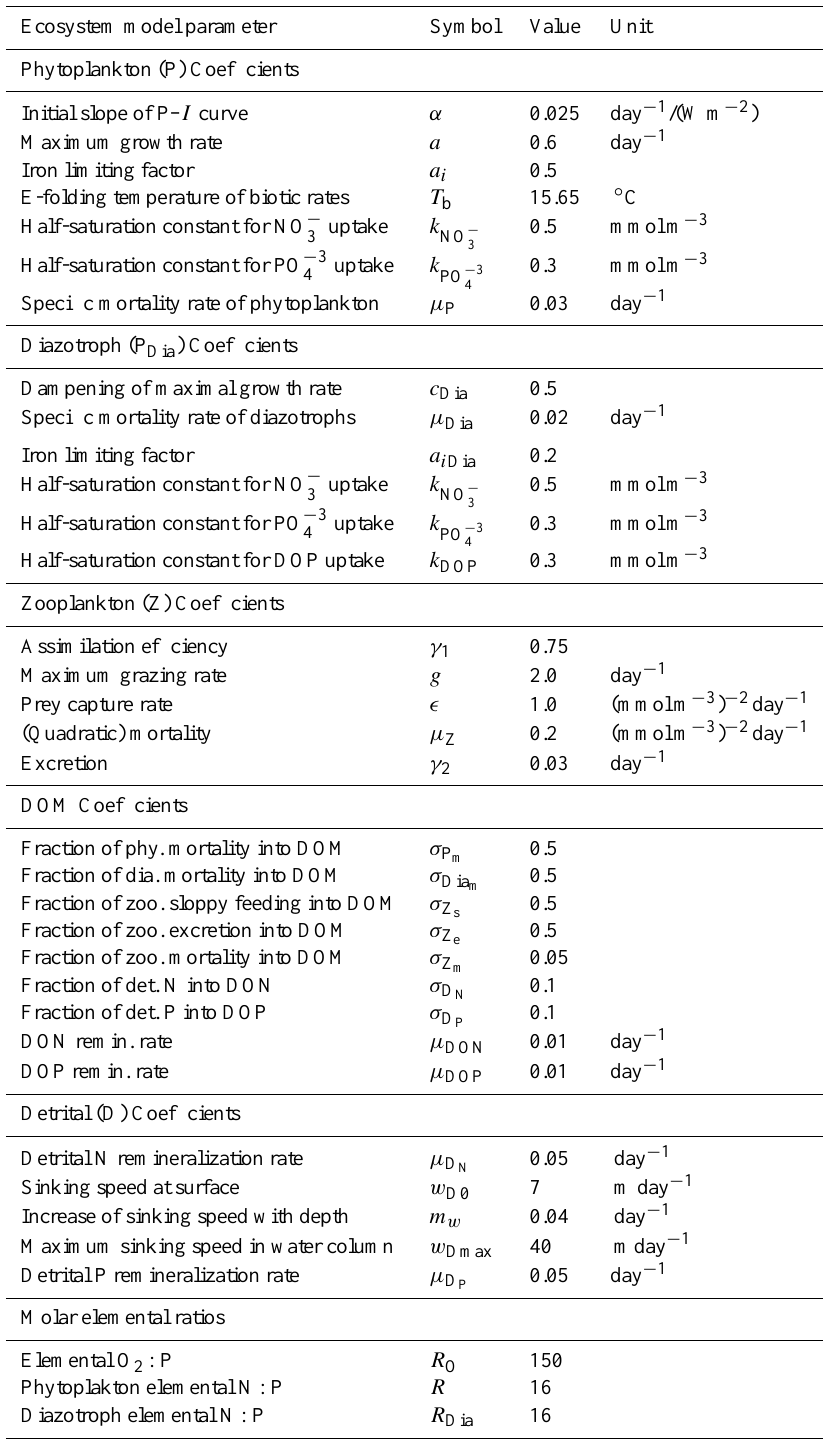
Table A1. Ocean ecosystem model parameters. Ecosystem model parameter